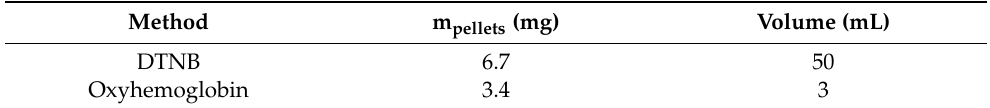
Table 1. Experimental conditions used in the H 2 S/NO release studies.